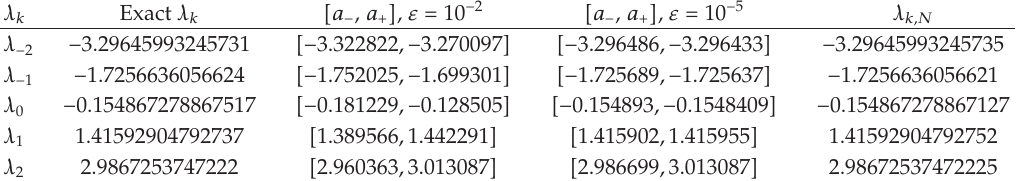
Table 4: The approximation λ k,N and the exact solution λ k are all inside the interval (cid:3) a − , a (cid:9) (cid:4) for di ff erent values of ε